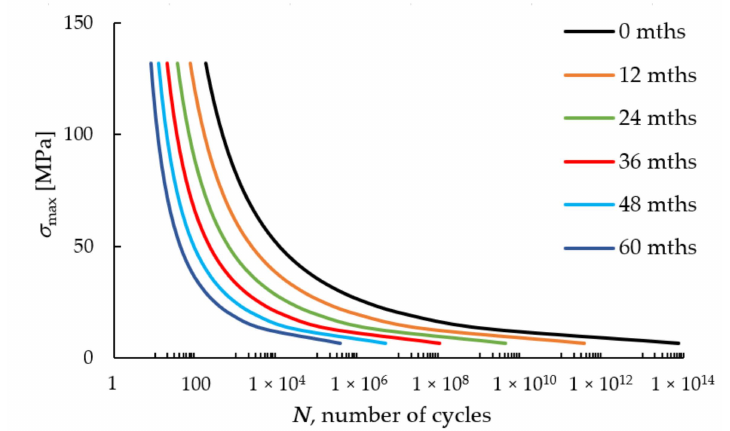
Figure 4. S–N curve change, UD0 ◦ polyester/glass composite.